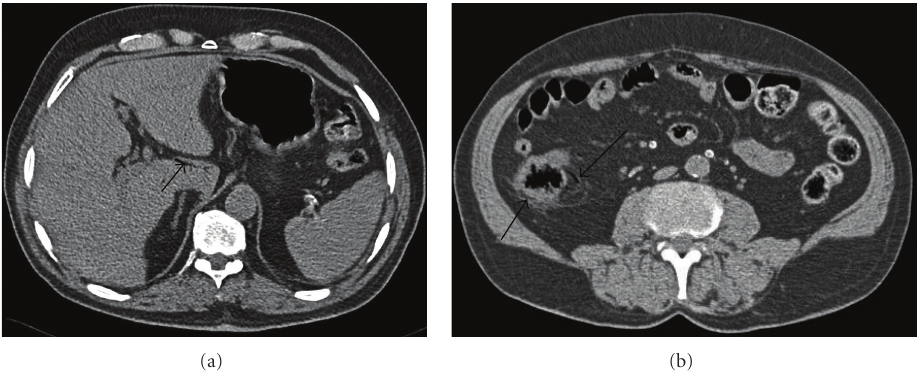
Figure 2: (a) Noncontrast CT image of the liver demonstrates intraluminal gas in a portal venule in the caudate lobe (arrow). (b) Noncontrast CT image through the lower abdomen demonstrates cecal wall thickening with fat stranding and linear pneumatosis intestinal within the cecal wall with intraluminal gas in adjacent mesenteric venules (arrows). Note the calcified mesenteric artery